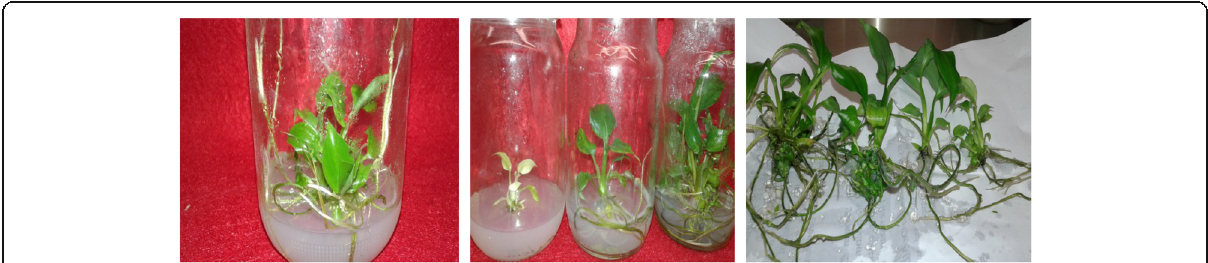
Fig. 1 Spathyiphyllum cannifolium during multiplication stage (without radiation